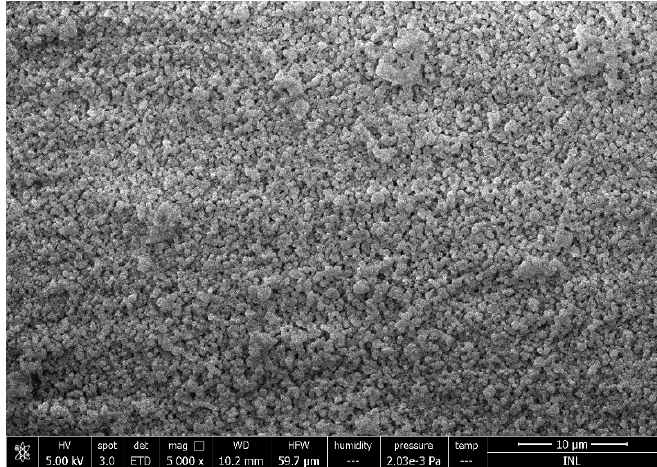
Figure 1. Lactoferrin particles at the submicron scale produced by a nanospraydrier. The image was obtained by scanning electron microscopy.